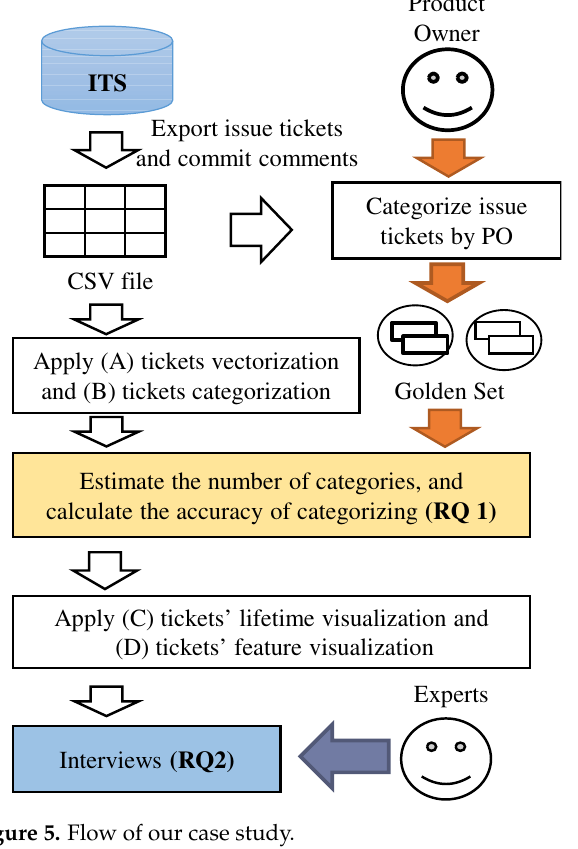
Figure 5. Flow of our case